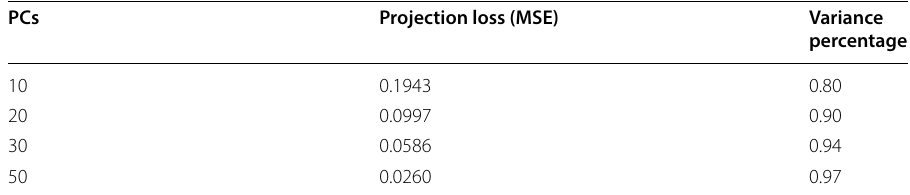
Table 4 The projection loss of the principal components